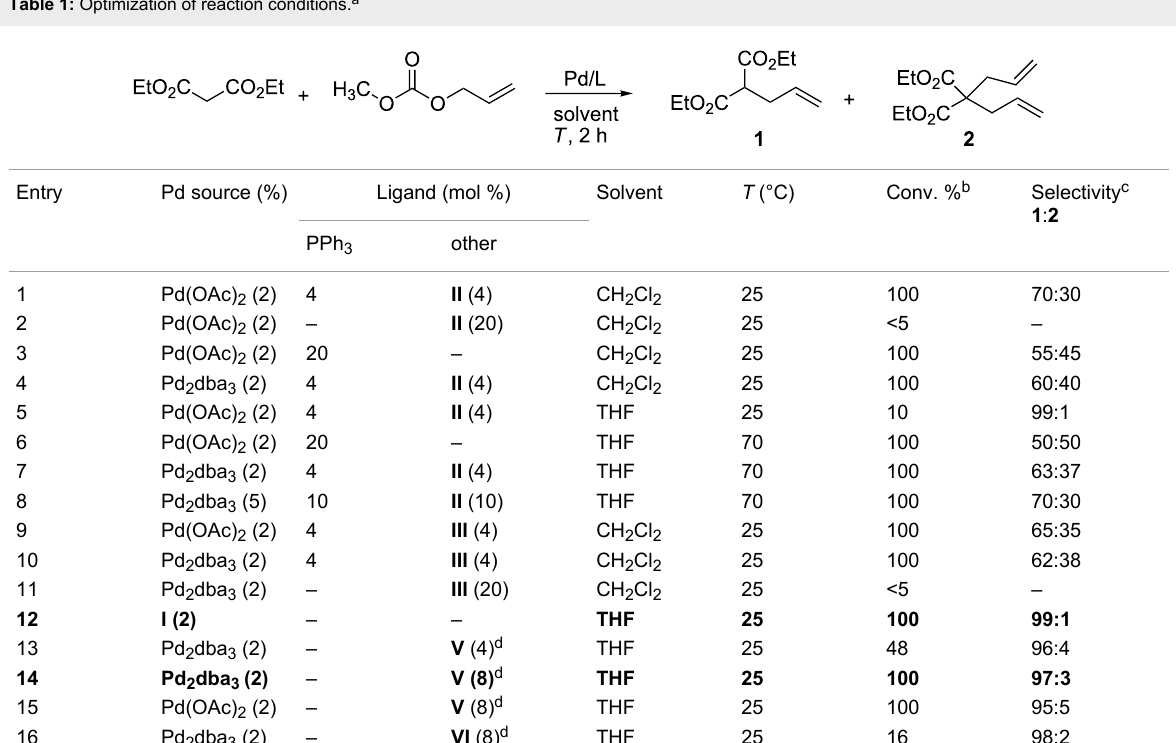
Table 1: Optimization of reaction conditions.